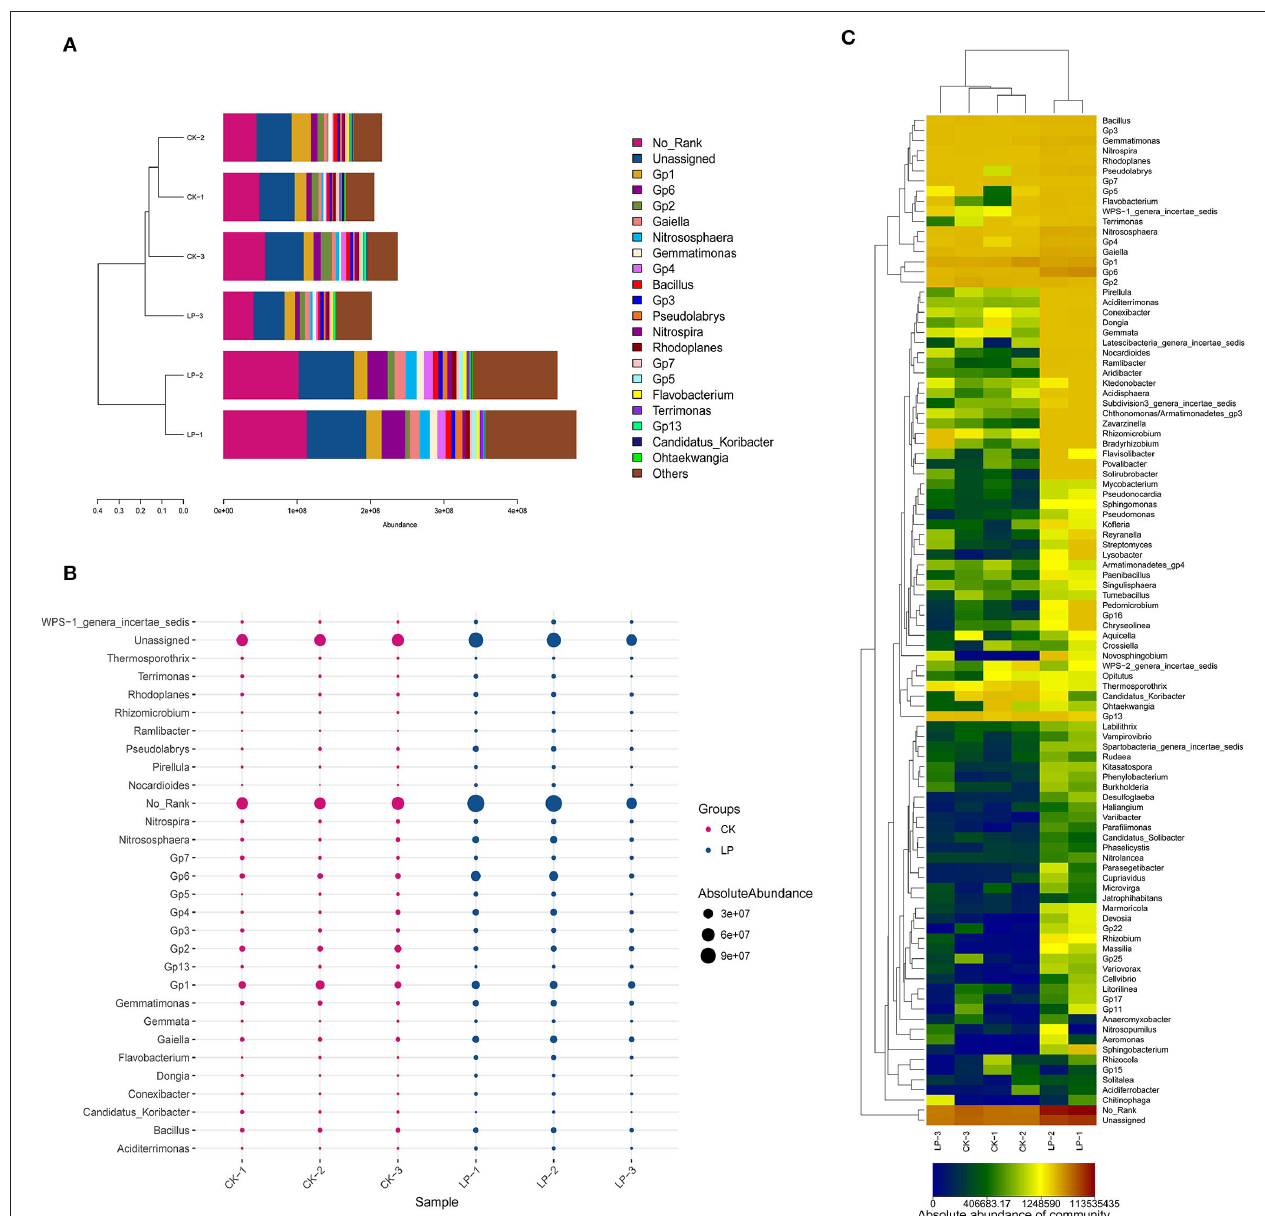
FIGURE 5 | Compositional analysis of bacterial community at the genus level. (A) Bar plot of the compositional alteration of the soil bacteria in the intercropping group (the proportion > 1%). (B) The bubble chart with changes of absolute abundance ( > 1%) in soil bacteria between LP and CK groups. (C) Heat map of soil different bacterial compositions at the genus